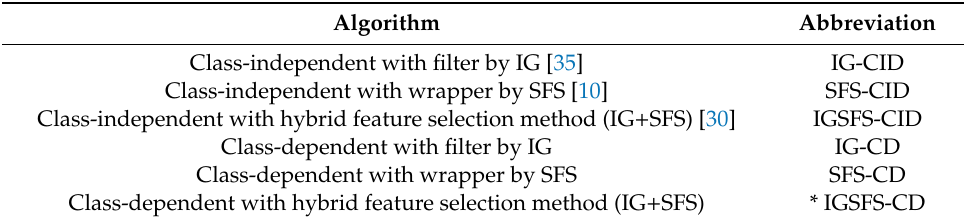
Table 1. Feature selection algorithms used in the present study and associated